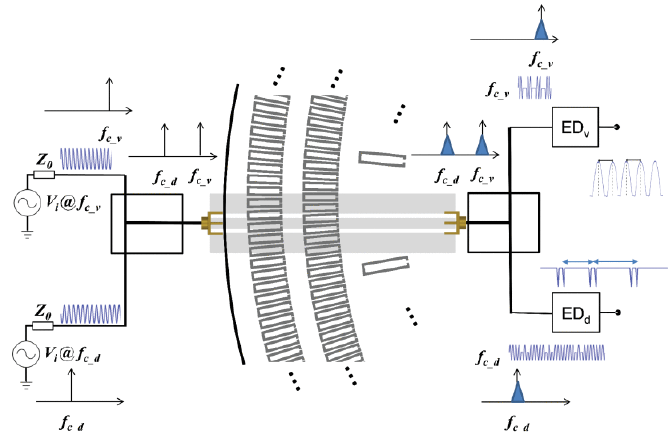
Figure 18. Sketch and working principle of the rotation sensor based on the edge configuration with two velocity chains and one direction detection chain. From [30], reprinted with permission.